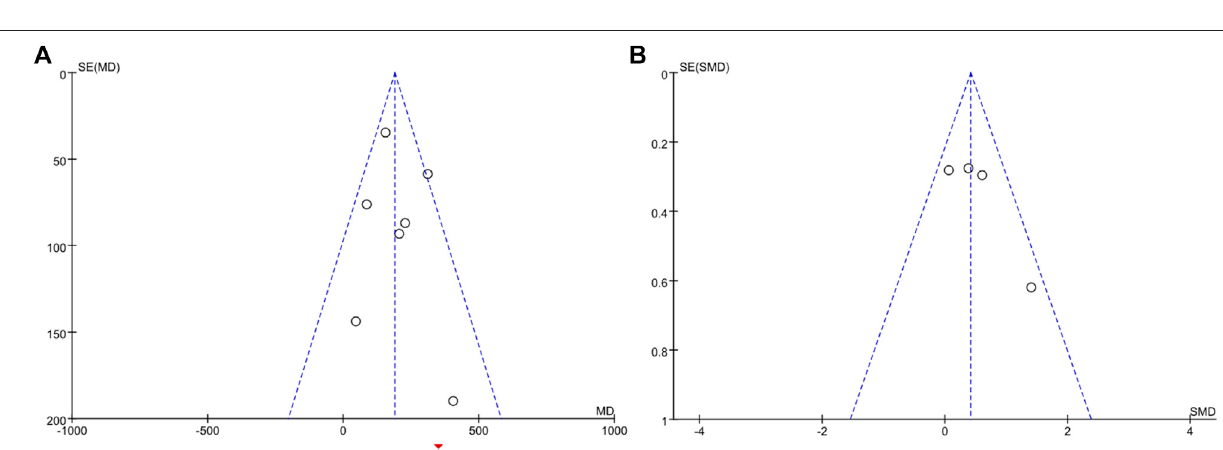
Frontiers in Physiology |